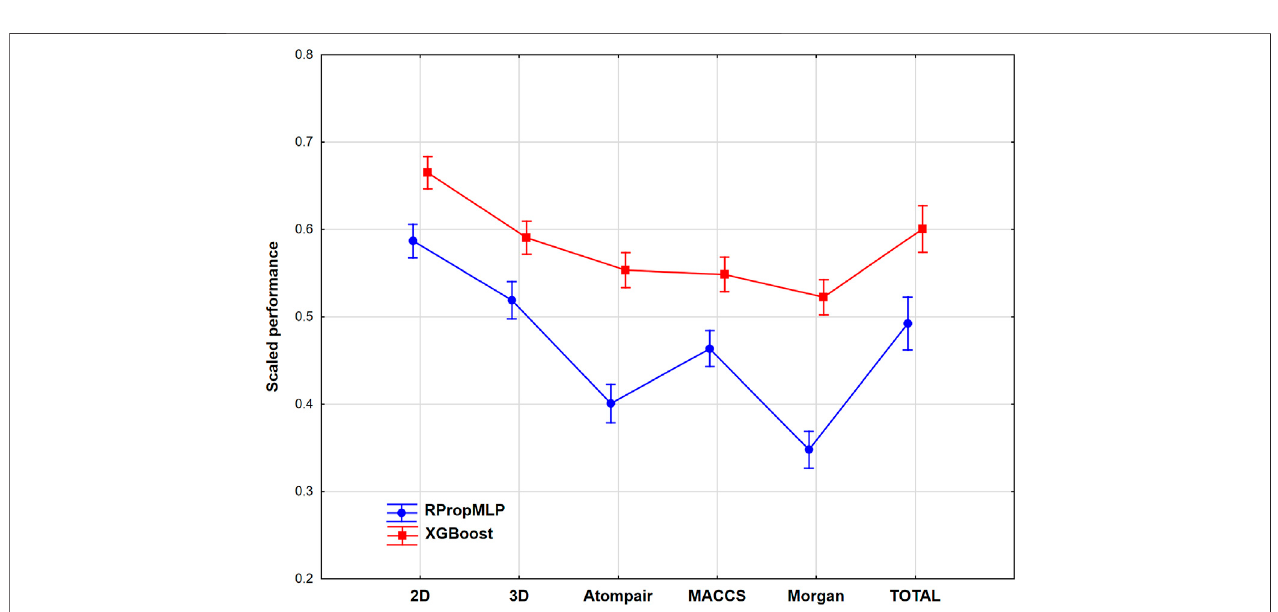
FIGURE 9 | Scaled performance parameters are plotted based on molecular descriptors and machine learning methods. The 18 performance parameters were range-scaledbetween0and1andaveragedacrossallmodelswiththegivendescriptortypes/MLalgorithms.Meanofthescaledperformanceparametersandthe95% con fi dence intervals are presented for each